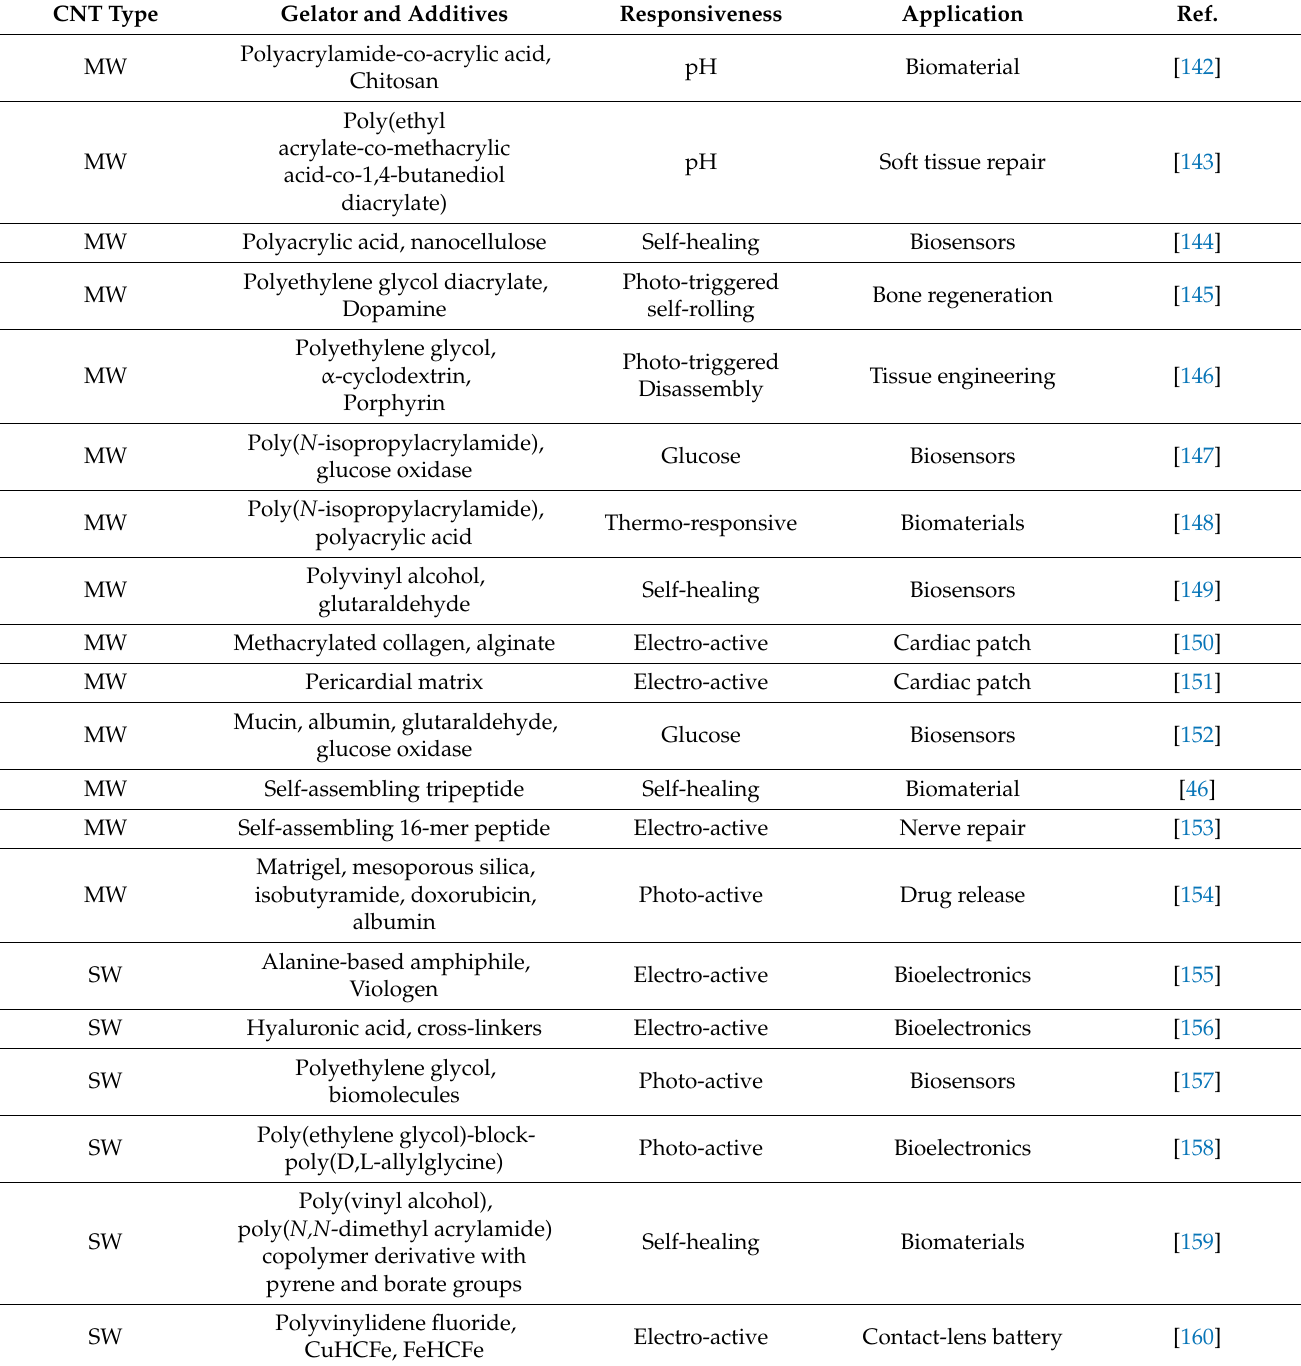
Table 2. Recent examples of smart hydrogels with CNTs for biomedical applications. MW = multi-walled. SW = single-walled. CNT